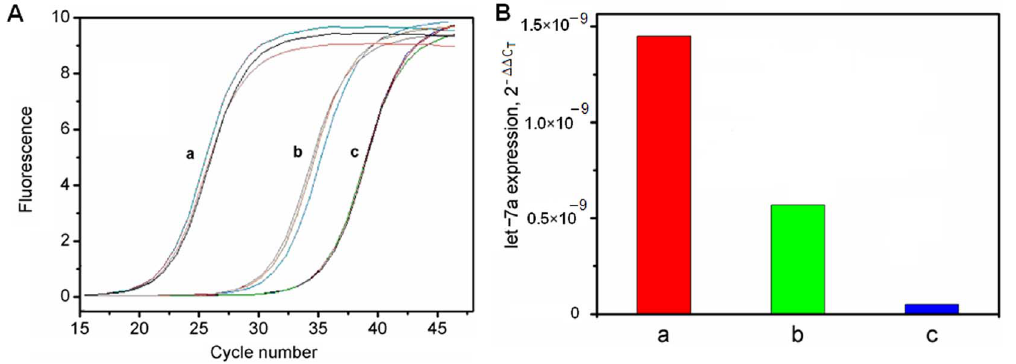
Figure 3. Real-time PCR detection of pre-micRNA let-7a expression. (a) normal human vascular endothelial cells, (b) MCF-7 and (c) MDA-MB- 231 breast cancer cells.